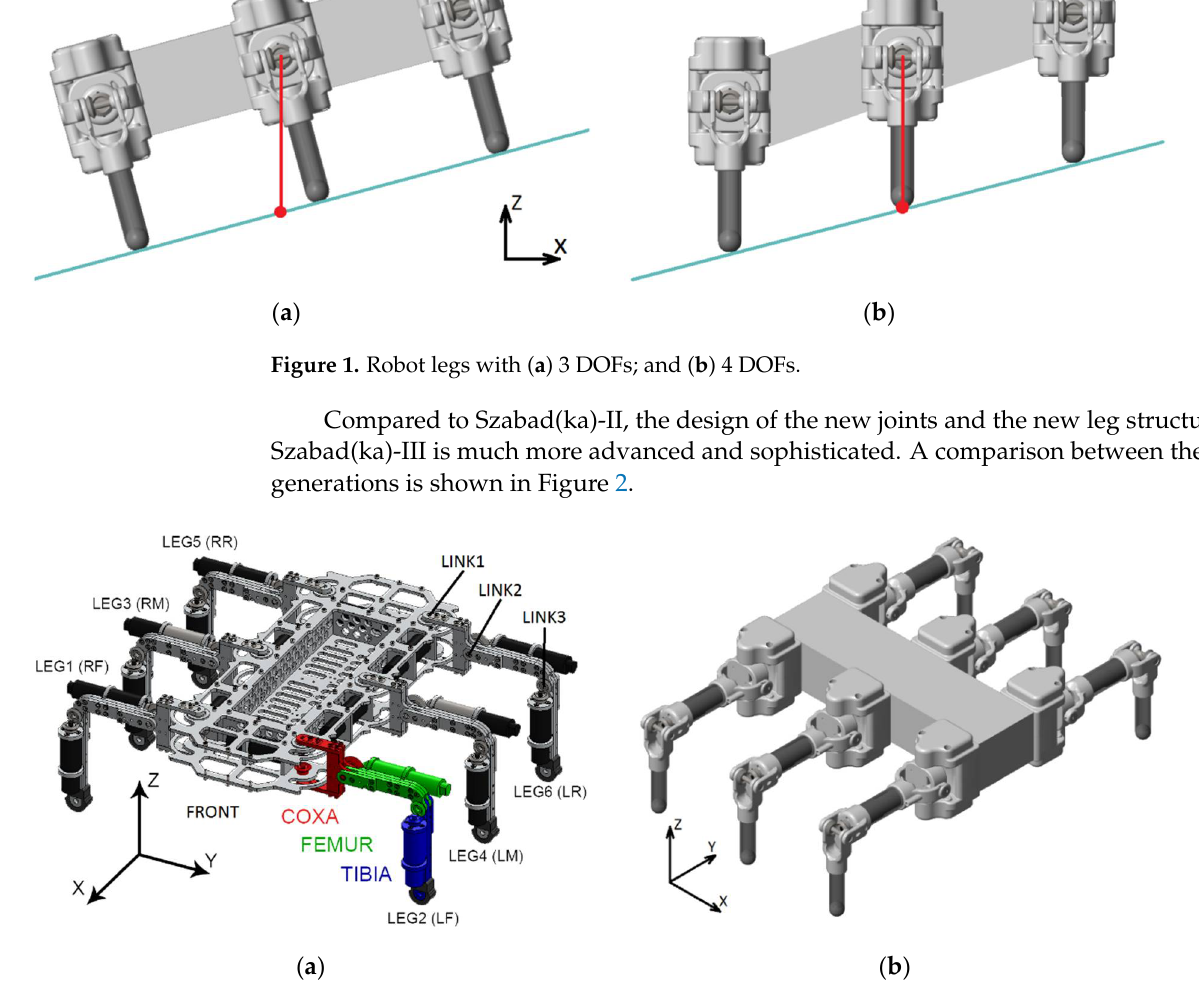
Figure 1. Robot legs with ( a ) 3 DOFs; and ( b ) 4 DOFs.